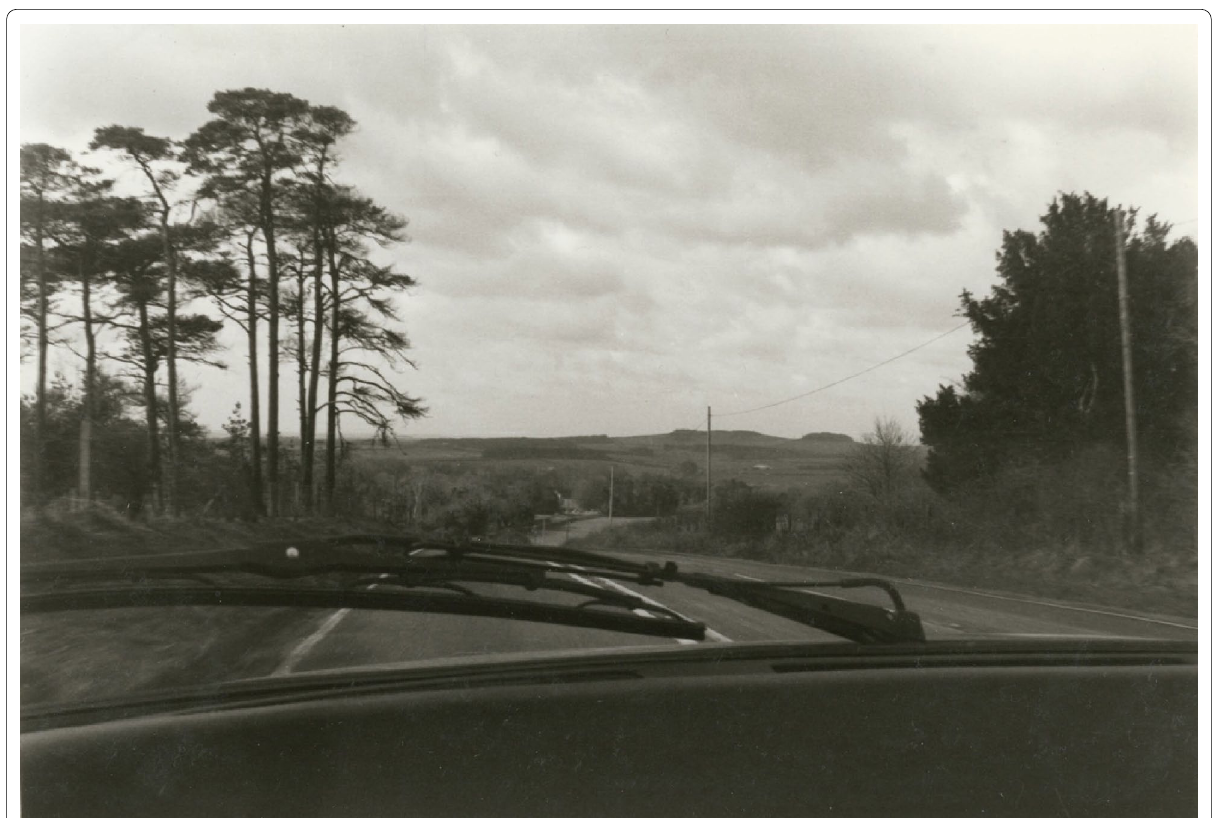
Fig. 8 Photograph taken from Citroën CX, Spring, 1982. Photograph by Alison Smithson. Credits: Smithson Family